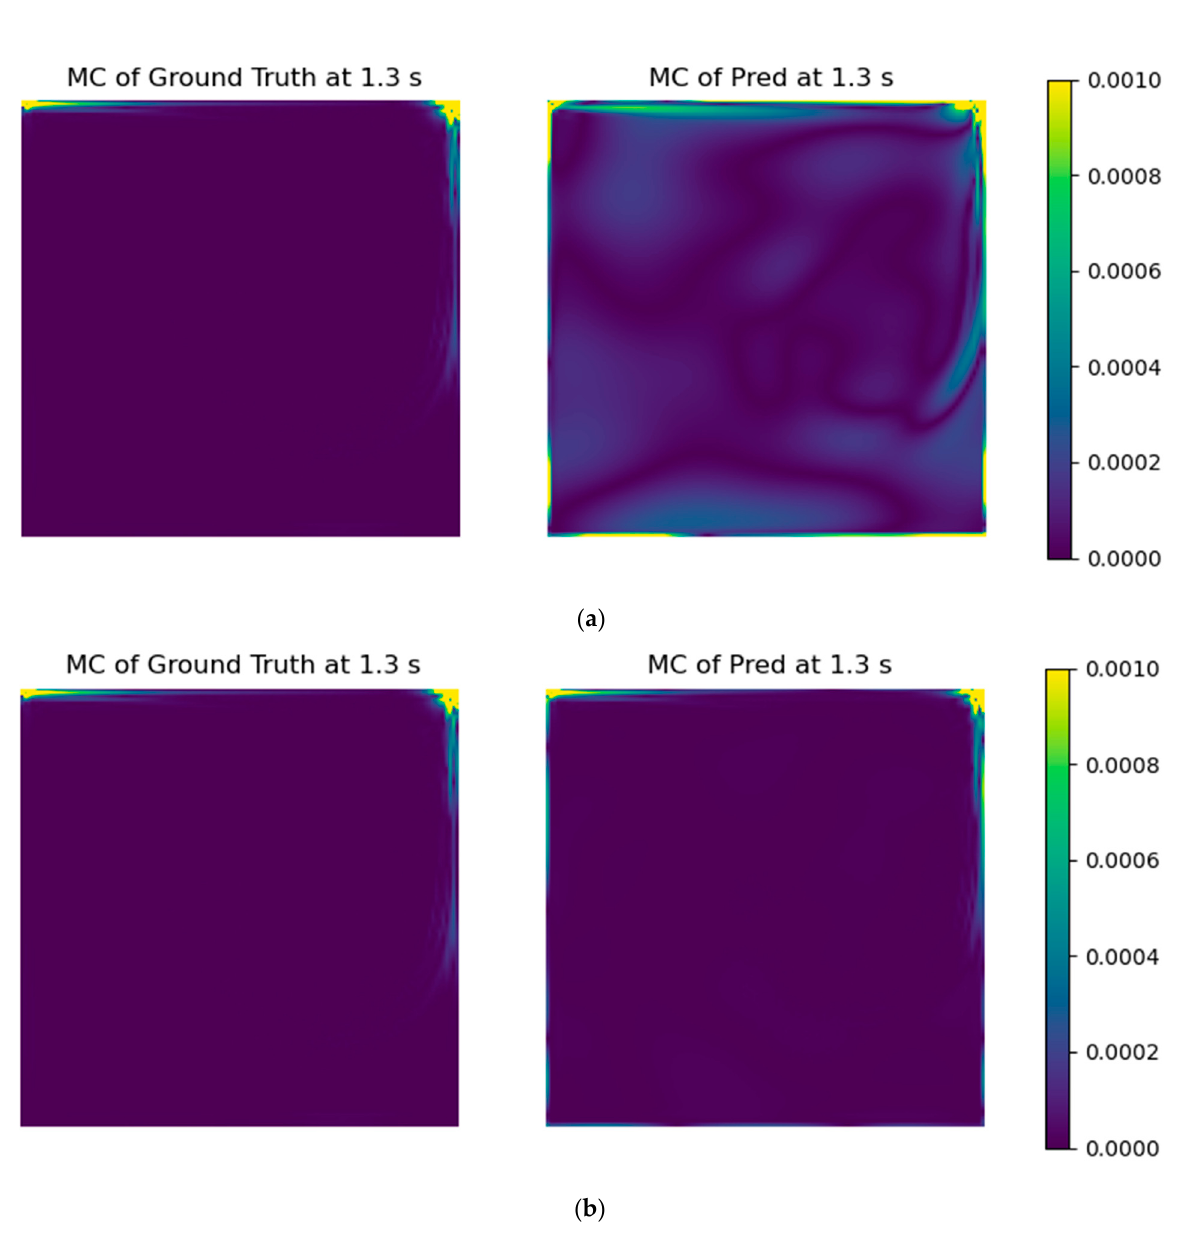
Figure 7. Mass imbalance (kg·s − 1 ·m 2 ) fields without ( a ) and with ( b ) the mass conservation error. The plots on the left are the ground truth fields, and the ones on the right were obtained using the DNN FNO model.